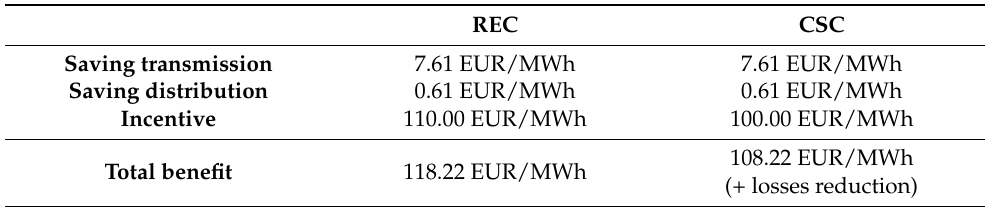
Table 1. Savings and incentive for the Italian renewable energy communities and jointly acting re- newable self-consumers (i.e., collective self-consumption: CSC). Saving transmission and distribution from [6], incentive from